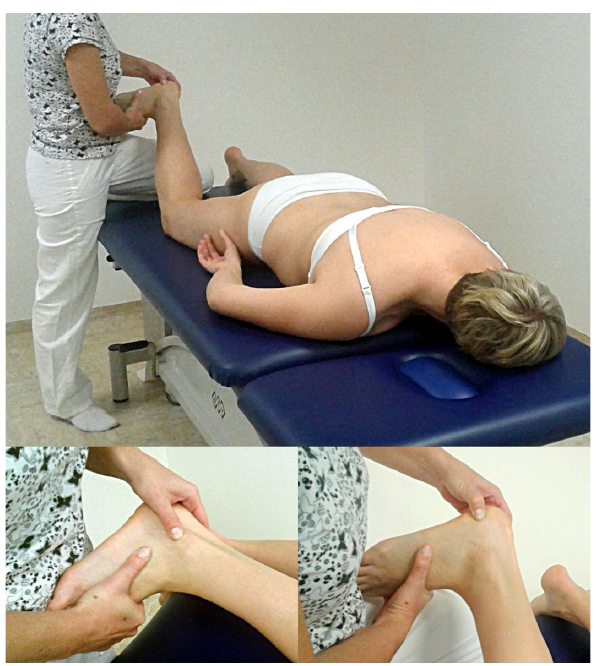
Fig. 2. Stimulation procedure and stimulation sites. The upper photograph shows the body position during the stimulation. The lower right photograph shows the stimulation site (zone) at the right lateral heel according to Vojta, whereas the lower left photograph shows the control stimulation site at the right lateral